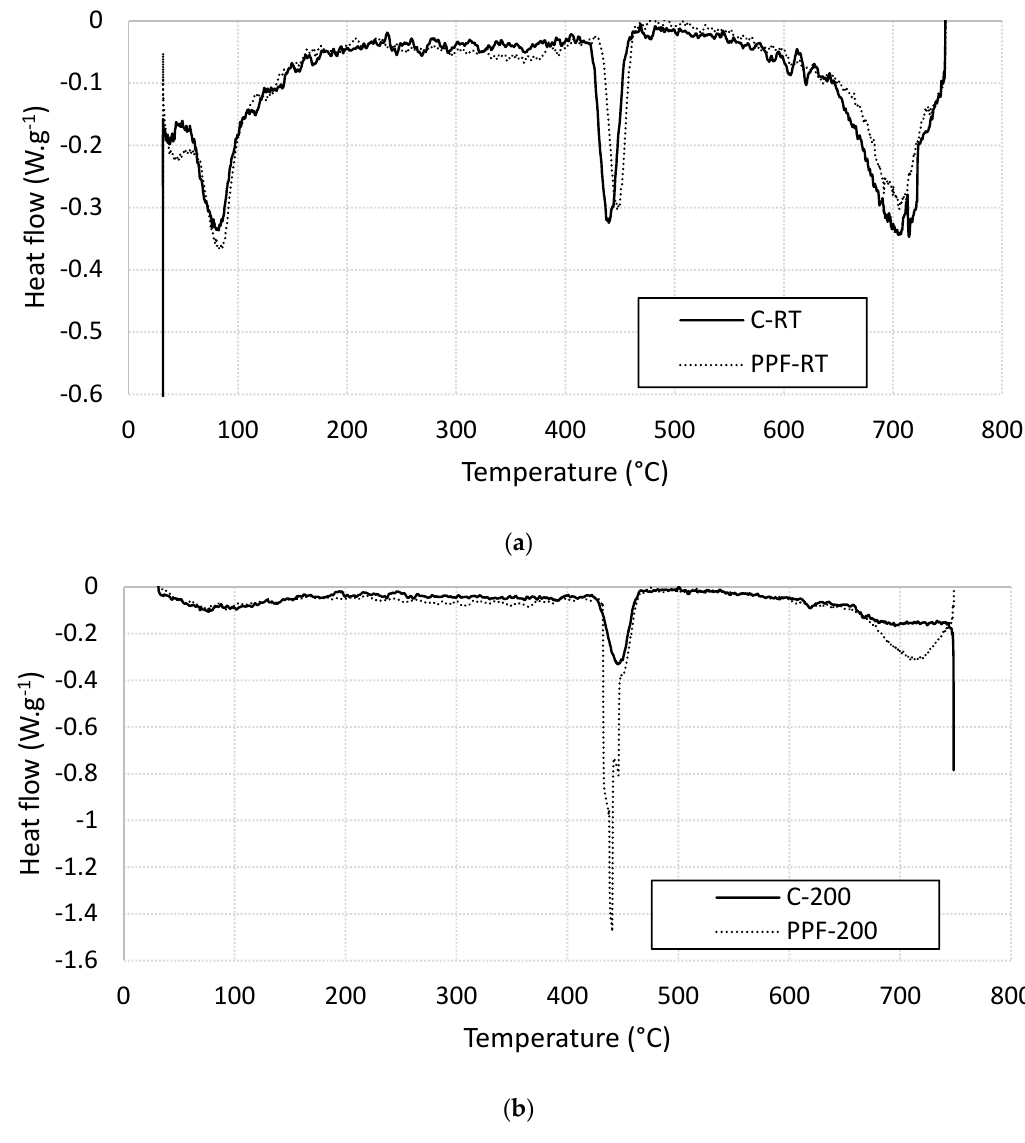
Figure 10. Differential scanning calorimetry (DSC) thermographs for plain and fiber-reinforced specimens ( a ) at room temperatures ( b ) heated at 200 °C .